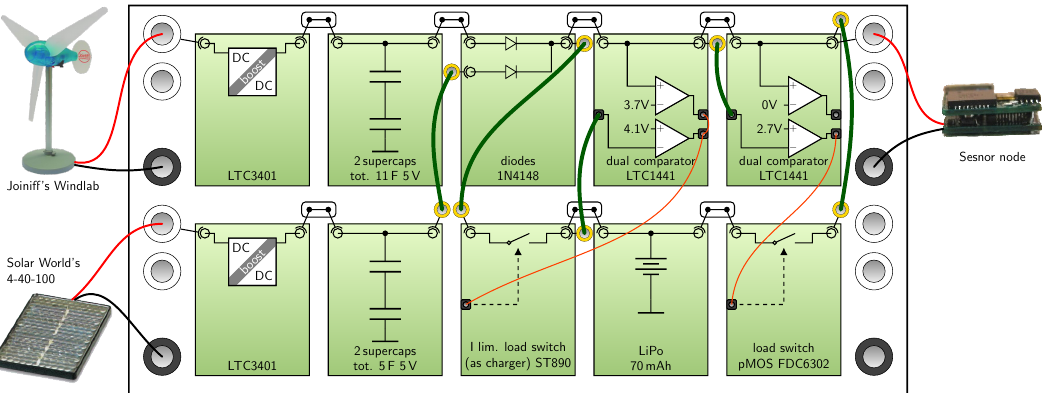
Figure 7. Power management of Ambimax [18] rebuilt with Medlay.